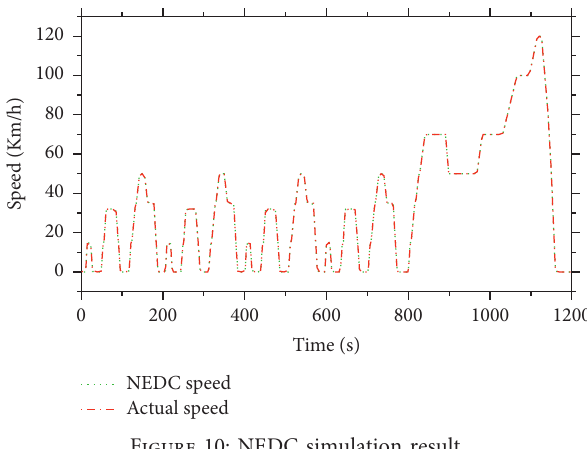
Figure 10: NEDC simulation